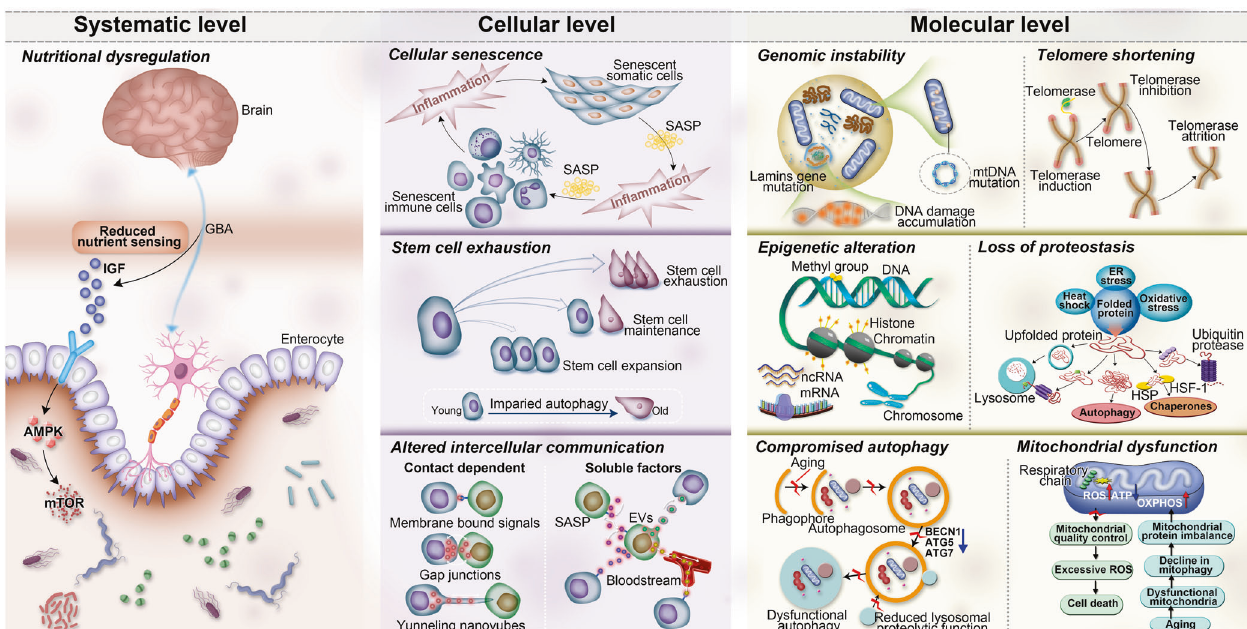
Fig. 2 The ten hallmarks of aging are subdivided into three categories: molecular hallmarks (genomic instability, telomere dysfunction, epigenetic alterations, loss of proteostasis, compromise of autophagy, and mitochondrial dysfunction), cellular hallmarks (cellular senescence, stem cell exhaustion, and altered intercellular communication), and systemic alterations (deregulated nutrient sensing). AMPK protein kinase AMP-activated catalytic subunit alpha 1, ATG5: autophagy-related 5, ATG-7 autophagy-related 7, ATP adenosine triphosphate, BECN1 Beclin 1, ER endoplasmic reticulum stress, EVs extracellular vesicles, GBA gut – brain axis, HSF-1 heat shock factor-1, HSP heat shock protein, IGF insulin- like growth factor-1, mtDNA mitochondrial DNA, mRNA messenger RNA, mTOR mechanistic target of rapamycin kinase, ncRNA noncoding RNA, OXPHOS oxidative phosphorylation, Rb retinoblastoma, ROS, reactive oxygen species, SASP senescence-associated secretory